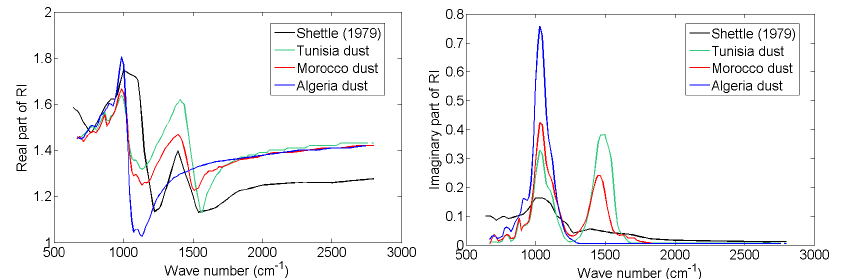
Figure 5. Complex refractive indices used as input in the radiative transfer calculations. Left plot: real part of Shettle and Fenn (1979) (black curve) and of the three indices (red, green, and blue curves) derived by Di Biagio et al. (2017); right plot: same as left, but for the imaginary part.